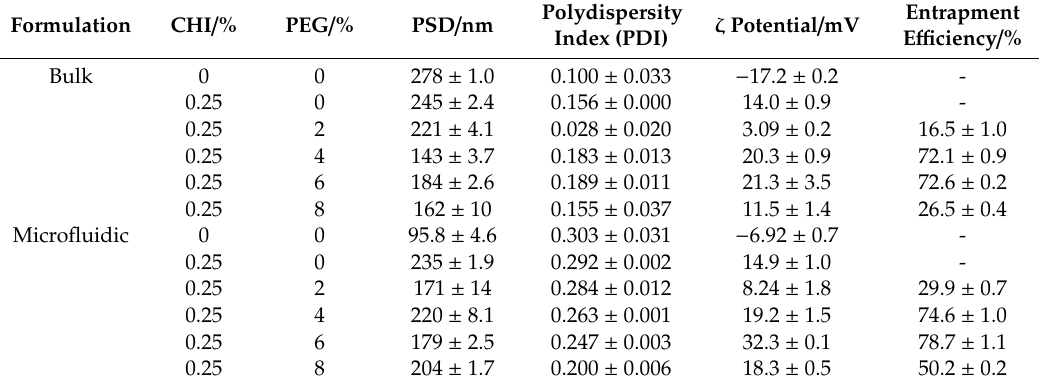
Table 1. Size, dispersity, surface charge and entrapment e ffi ciency of bulk and microfluidic prepared formulations with varying amounts of PEG